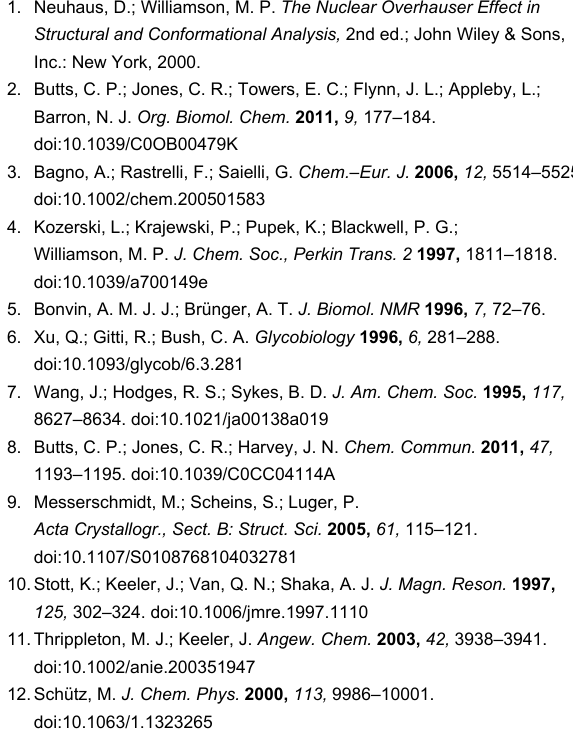
Experimental NMR samples were prepared in 5 mm tubes with 0.7 ml CDCl 3 and ~10 mg 4-propylaniline, in air without degassing.